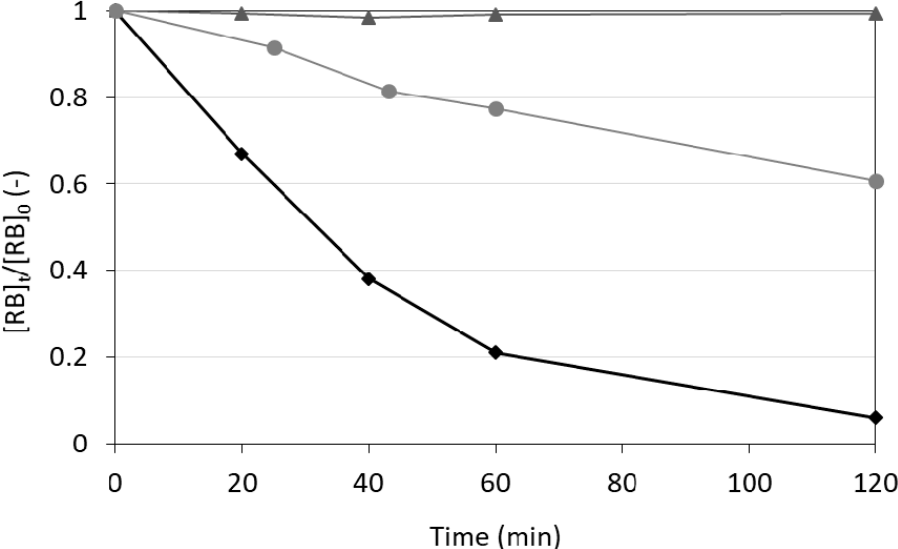
Figure 9. RB degradation for ( ● ) pure TiO 2 , ( ♦ ) TiO 2 /Fe0.5/N43 films and ( ▲ ) without catalyst under LED light ( λ = 395 nm) as a function of time.